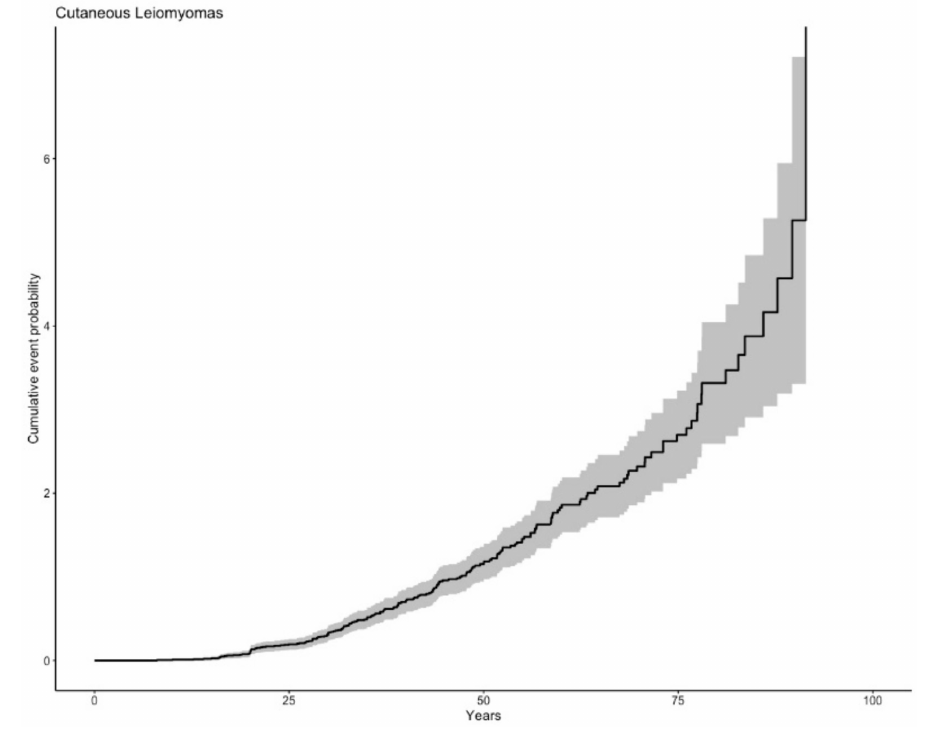
Figure 1. Cumulative incidence of cutaneous